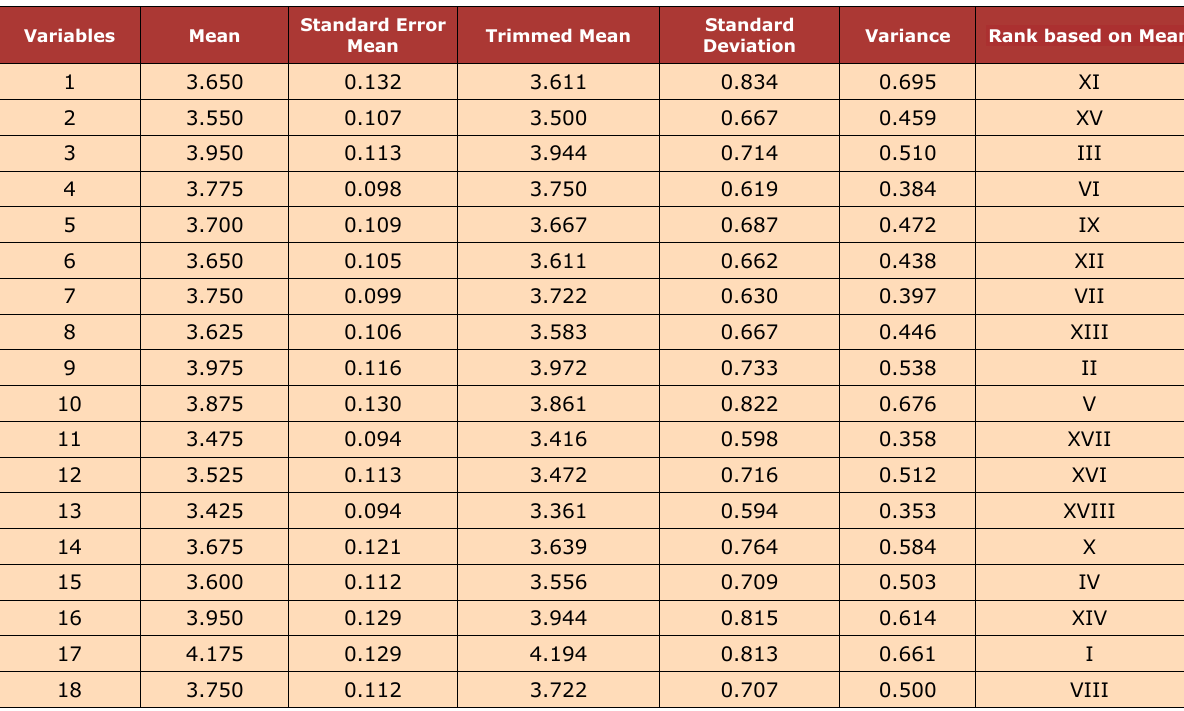
Table 3. Mean and Variance of the